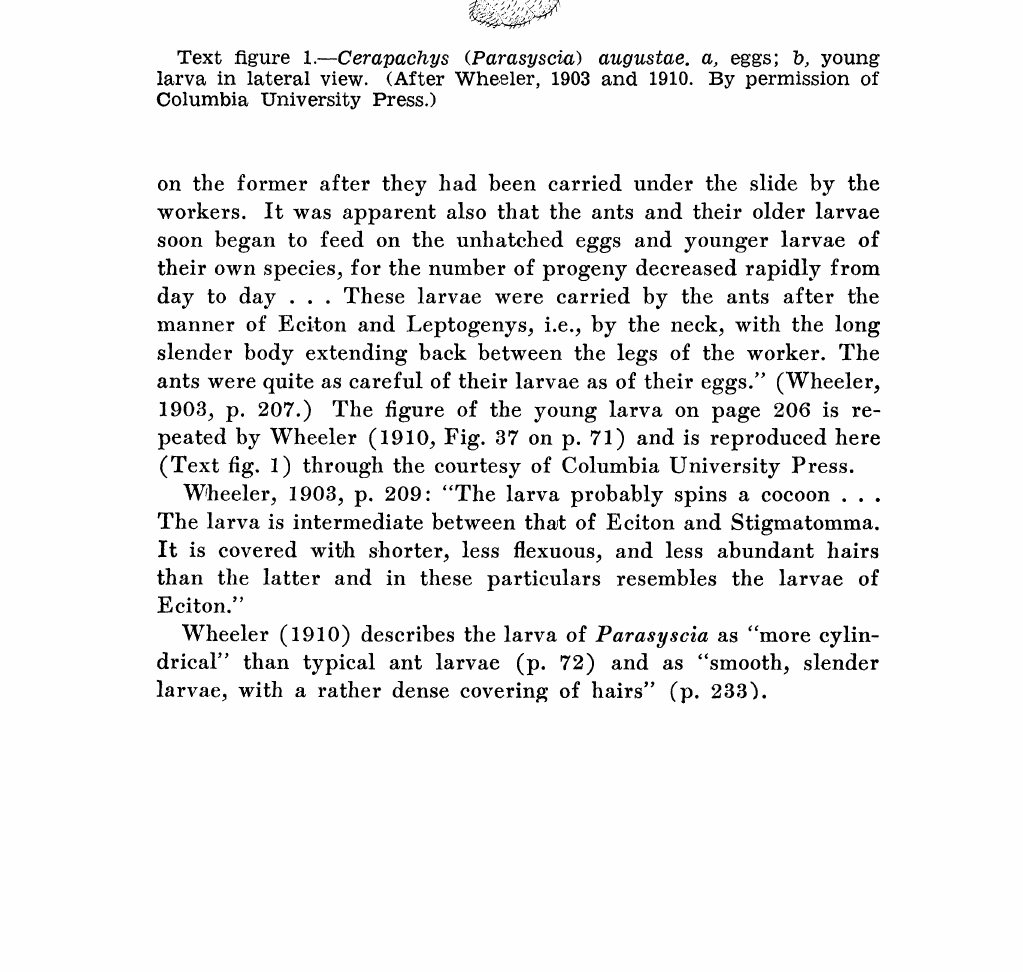
Text figure 1.--Cerapachys (Parasyscia) augustae, a, eggs; b, young larva in lateral view. (After Wheeler, 1903 and 1910. By permission of Columbia University